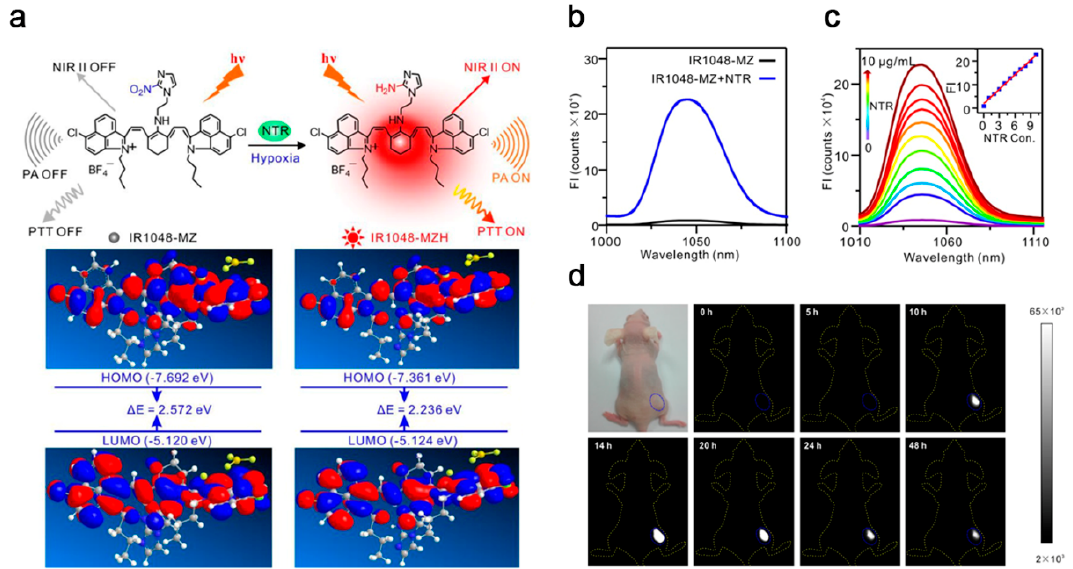
Figure 8. ( a ) Schematic diagram of the catalyzed mechanism of IR1048-MZ for hypoxia-activated NIR-II/PA tumor imaging. HOMO and LUMO energy levels of IR1048-MZ and IR1048-MZH were obtained by theoretical calculation. ( b ) Fluorescence spectra of IR1048-MZ with and without the addition of NTR. ( c ) NIR-II fluorescence spectra of IR1048-MZ (5 µ g/mL) in response to various concentrations of NTR. ( d ) Time-dependent NIR-II fluorescence imaging of tumor-bearing mice after injection of IR1048-MZ (40 µ g/mL, 200 µ L). Reproduced with permission [126]. Copyright 2018, Creative Com- mons.